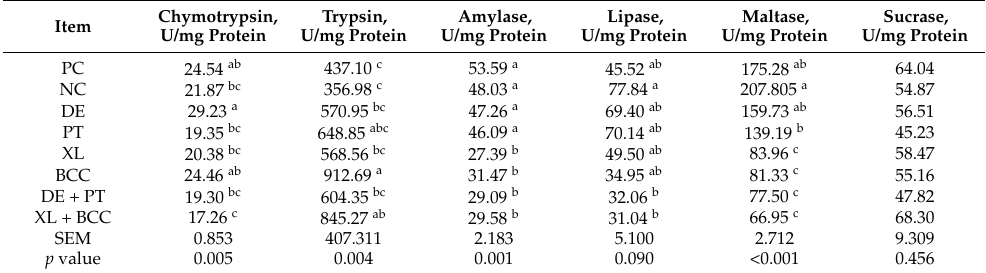
Table 7. Supplemental enzymes with probiotics on digestive enzyme activity of broiler chickens at 21